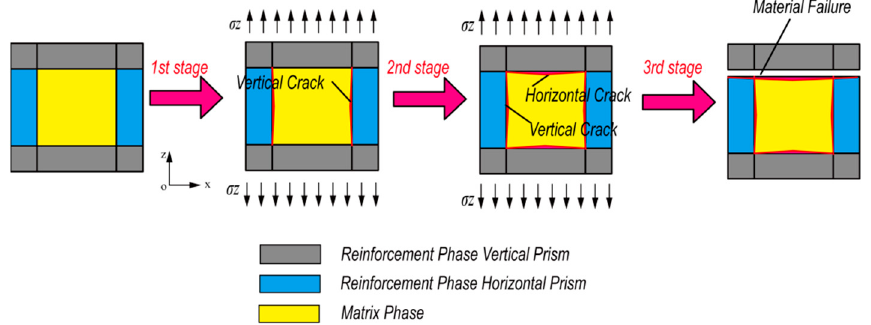
Figure 3. Process of tensile damage of the representative volume element.